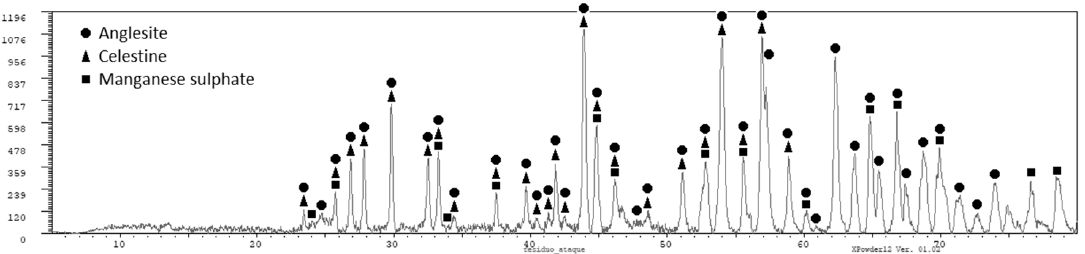
Figure 2. X-ray diffraction pattern for the residue of filtration.